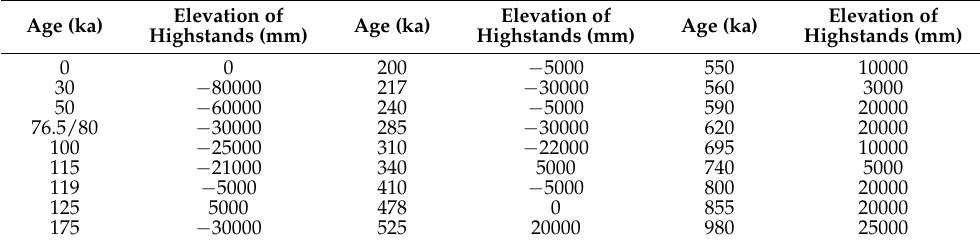
Table 2. Values of sea-level highstands derived from Siddall et al. (2003) and Rohling et al. (2014) used to calculate predicted palaeoshoreline elevations iterating values of uplift